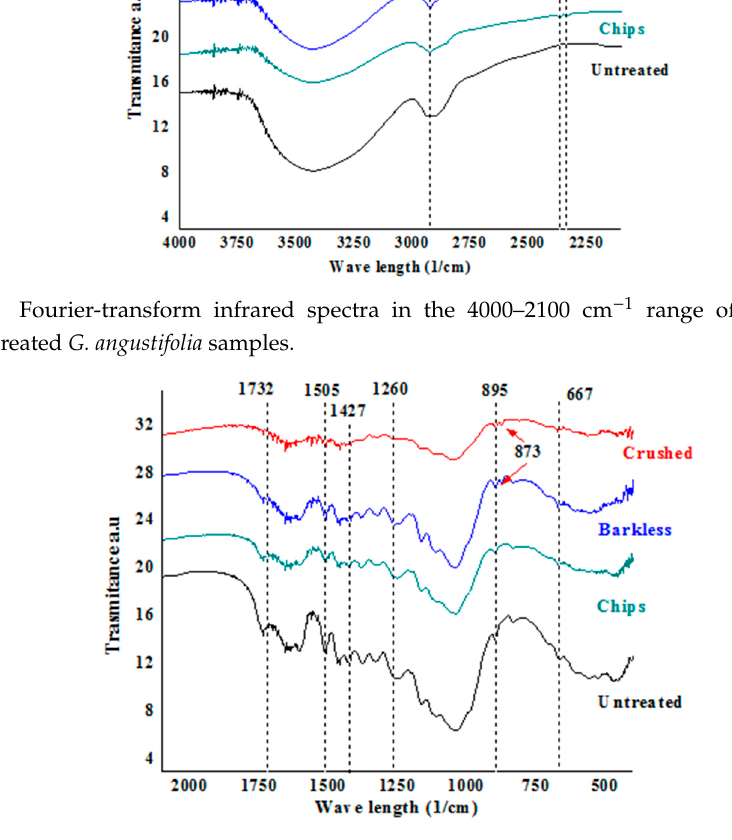
Figure 9. X-ray diffraction patterns of the untreated and Ca(OH) 2 -treated G. angustifolia samples, along with PDF #00-047-1743 calcite.